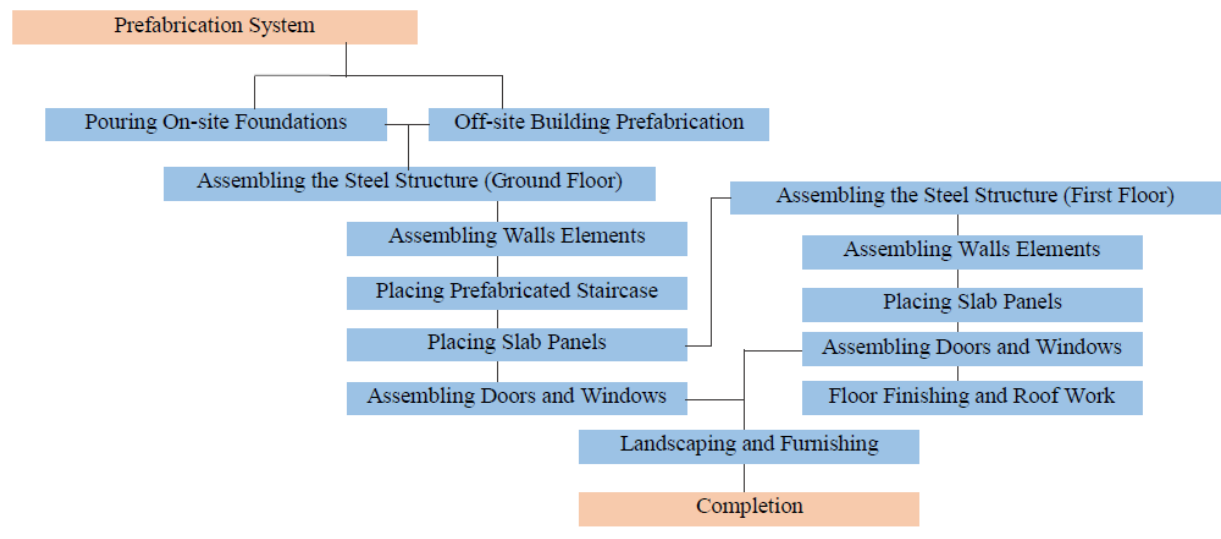
Figure 4. Work breakdown structure of the proposed housing paradigm.